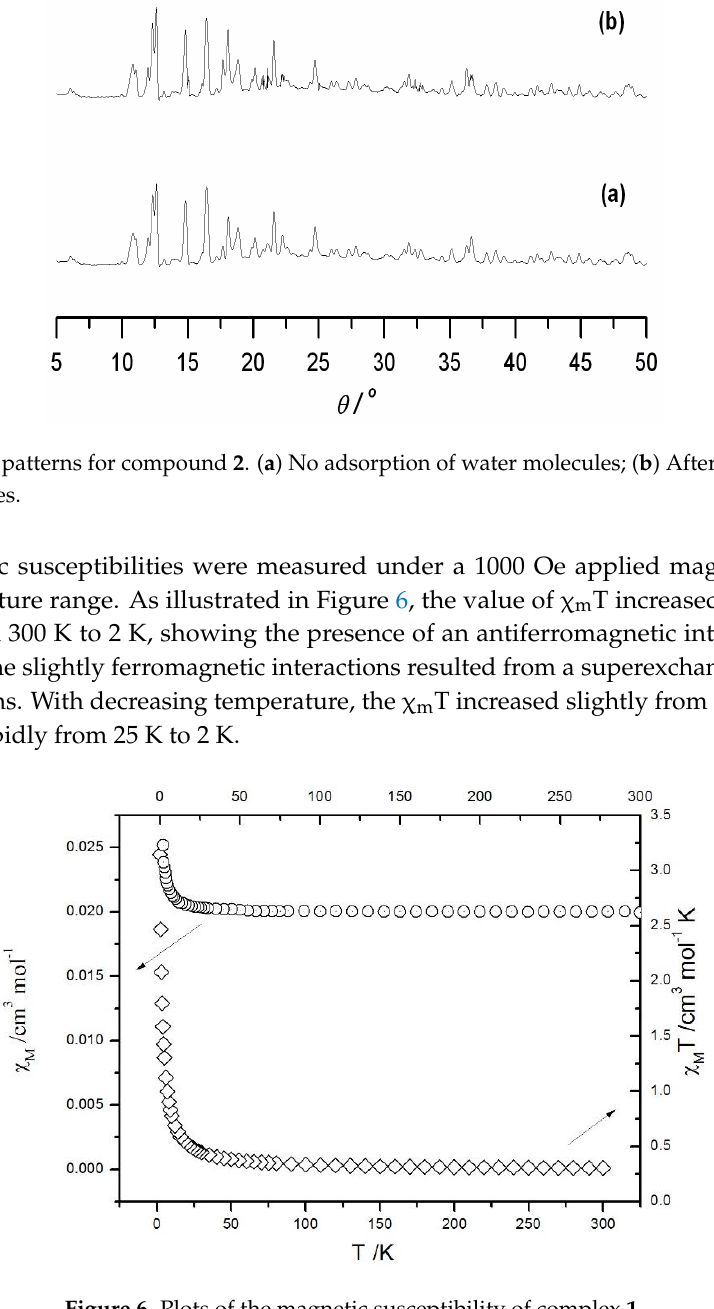
Figure 6. Plots of the magnetic susceptibility of complex 1 .